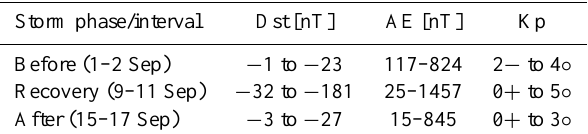
Table 4. Key parameters during the September 2002 geomagnetic storms. The intervals are those highlighted in the upper part of Fig.